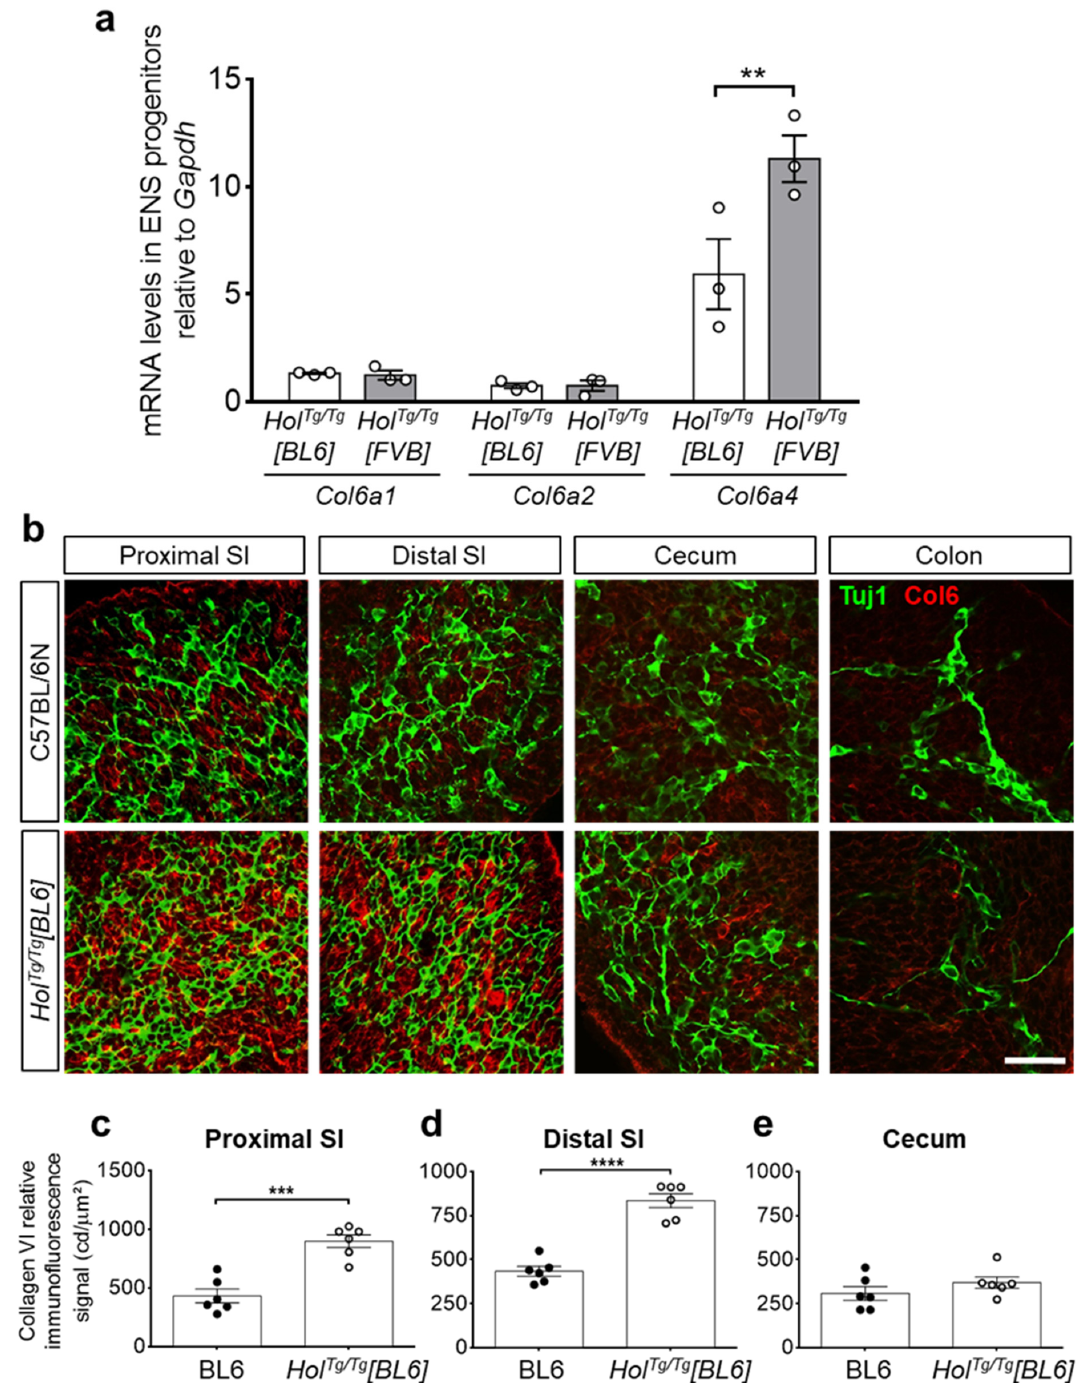
Figure 4. The increased gene expression of Col6a4 and secretion of collagen VI microfibrils are both lower in Hol Tg/Tg [BL6] embryos than in Hol Tg/Tg [FVB] embryos. ( a ) RT-qPCR analysis of Col6a1 , Col6a2 , and Col6a4 in e12.5 ENS progenitors recovered by FACS from Hol Tg/Tg [BL6]; G4-RFP and Hol Tg/Tg [FVB]; G4-RFP embryos. ** p < 0.01, two-way ANOVA with post-hoc Sidak’s test. ( b ) Double immunofluorescence staining of collagen VI microfibrils (Col6, red) and β III-tubulin+ neuronal progenitors (Tuj1, green) in e12.5 embryonic guts from control C57BL/6 and mutant Hol Tg/Tg [BL6] embryos. SI, small intestine. Scale bar, 20 µm. ( c – e ) Quantitative analysis of collagen VI immunofluorescence signal (in candella [cd] per µm 2 ) in e12.5 C57BL/6 and Hol Tg/Tg [BL6] guts, using images such as those displayed in panel b. *** p < 0.001, **** p < 0.0001, two-way ANOVA with post-hoc Sidak’s test.